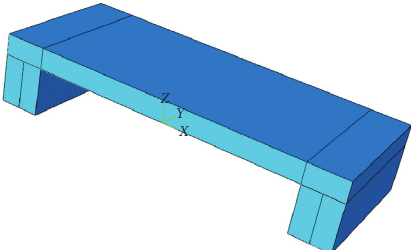
Figure 25: Overall finite element model of the composite slab.